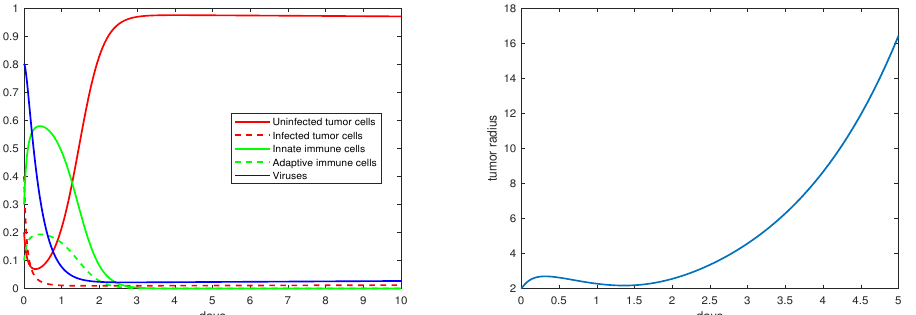
Figure 1. Simulation results for the base scenario. The values of the the parameters are: λ = 2, β = 3.5, k 1 = 2, k 2 = 2, s 1 = 56, s 2 = 56, c 1 = 2, c 2 = 2, δ = 5.6, k 0 = 1, γ = 2.5, µ = 2.1, b = 1.